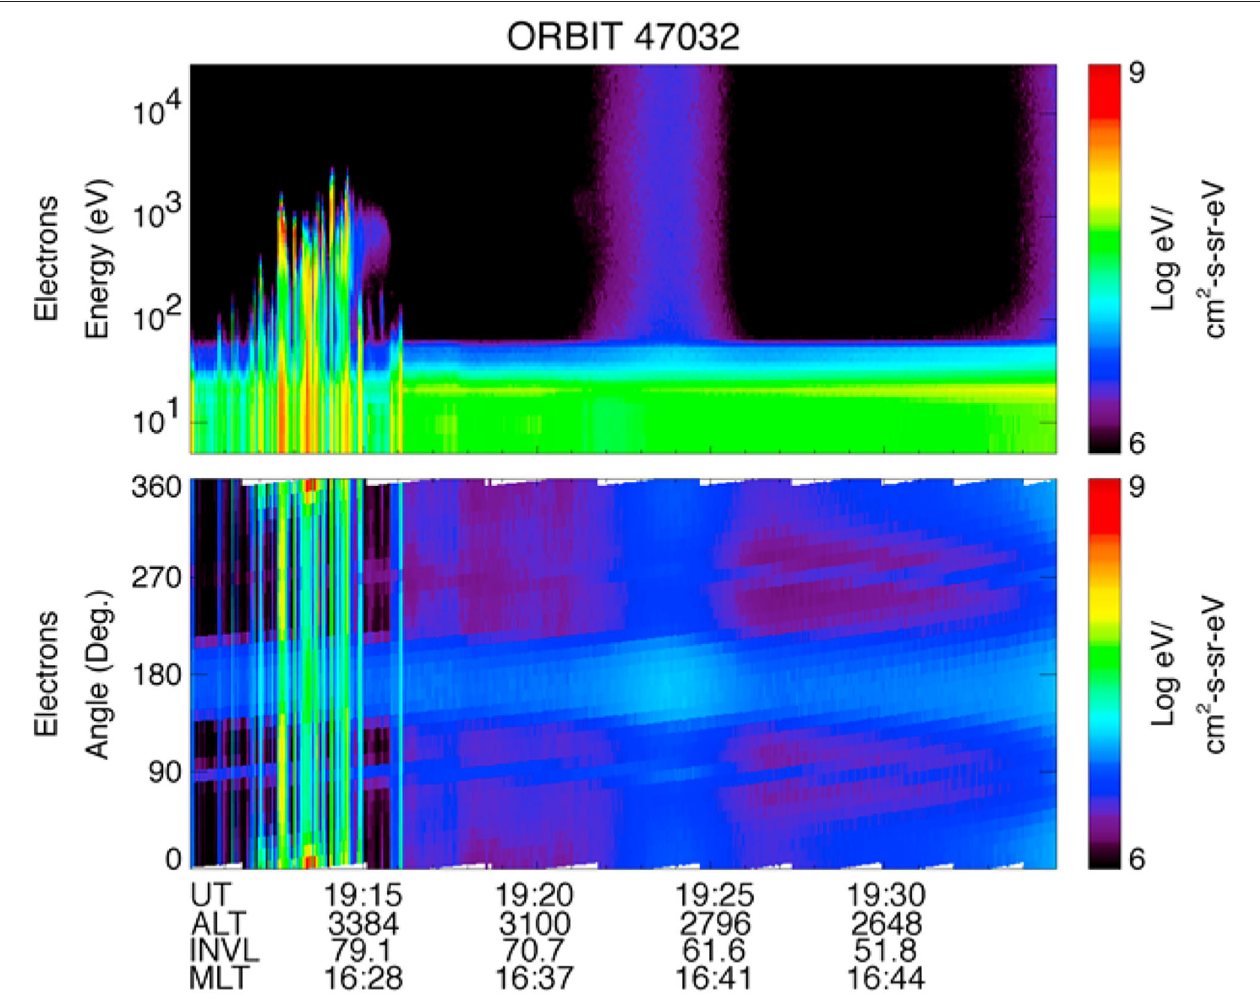
FIGURE 2 | Photoelectron energy flux energy-time (top) and angle-time (bottom) spectrograms from the FAST satellite on April 14, 2008, in units of (cm 2 -s-sr) − 1 , are shown by the color bars. Electron pitch angle β in the range 0–180 is related to the angle shown as β = min (φ ,360 − φ) where φ is the angle shown.